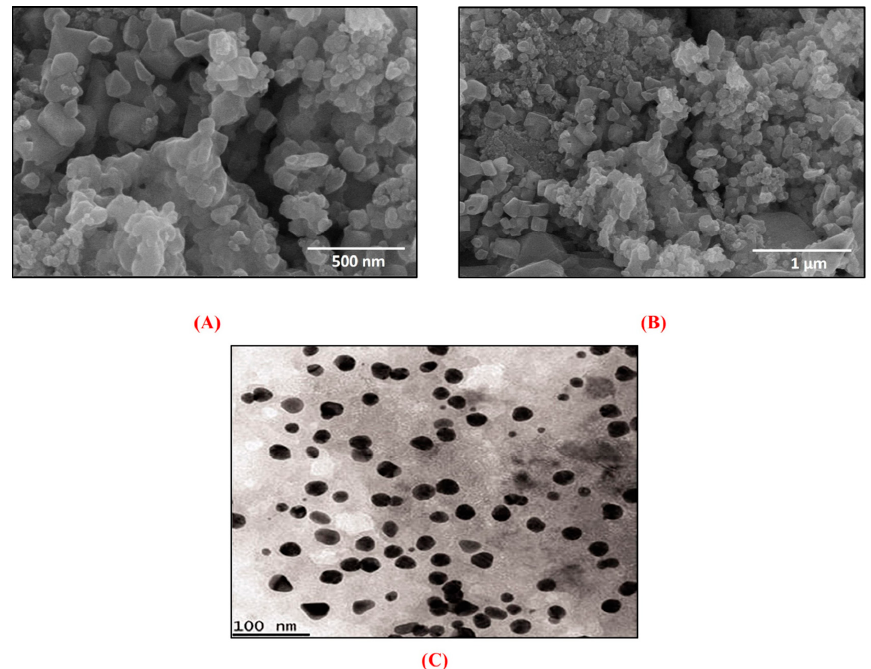
Figure 5. ( A,B ) Various SEM images of RT-NiONPs using nickel nitrate salt as a precursor ( C ) TEM images of RT- NiONPs.